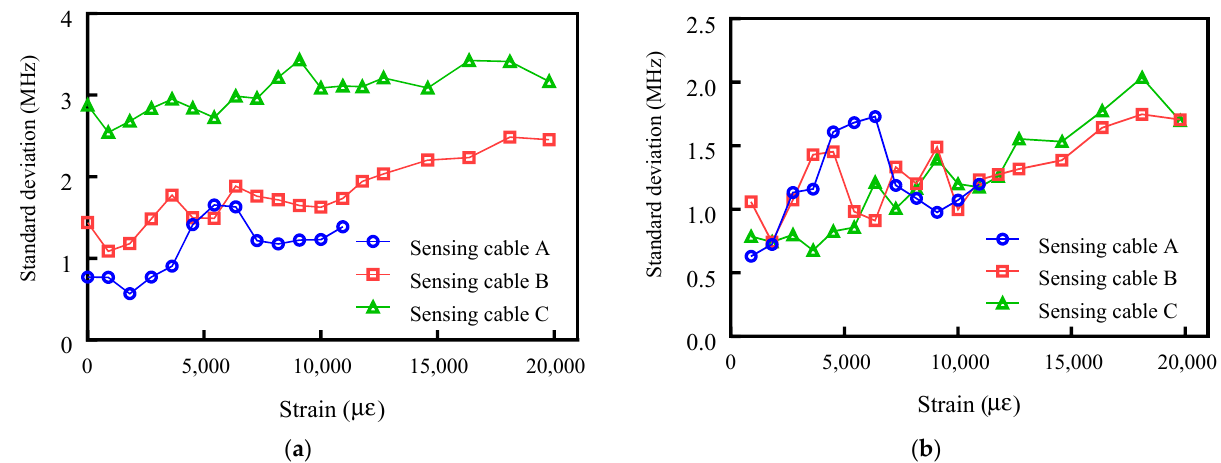
Figure 8. Standard deviation of ( a ) BFS and ( b ) BFS differences for three sensing cables under different strain conditions.